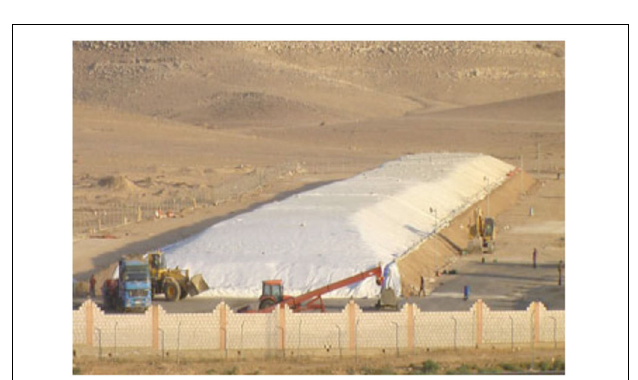
FIGURE 6 | GrainSafe in Guatemala storing maize.